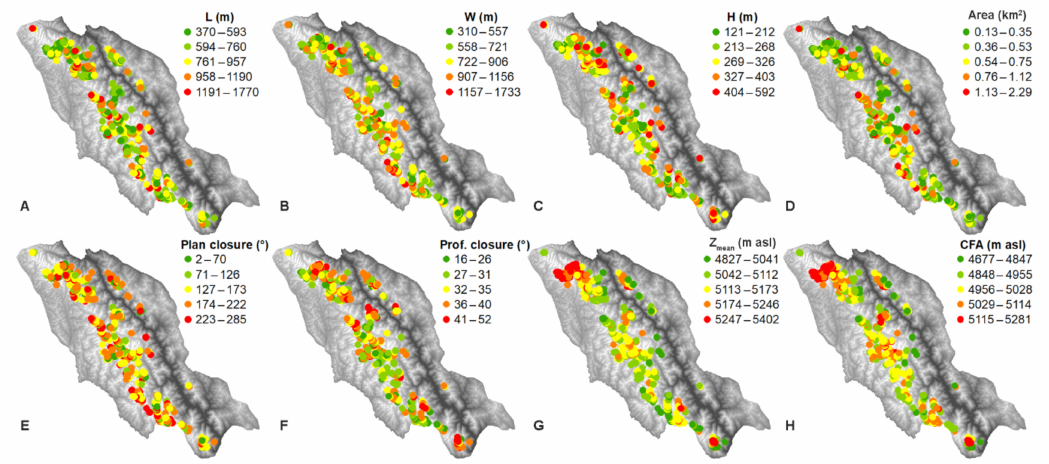
Figure 3. Spatial distributions of the cirque ( A ) L, ( B ) W, ( C ) H, ( D ) area, ( E ) plan closure, ( F ) profile closure, ( G ) Z mean , and ( H )